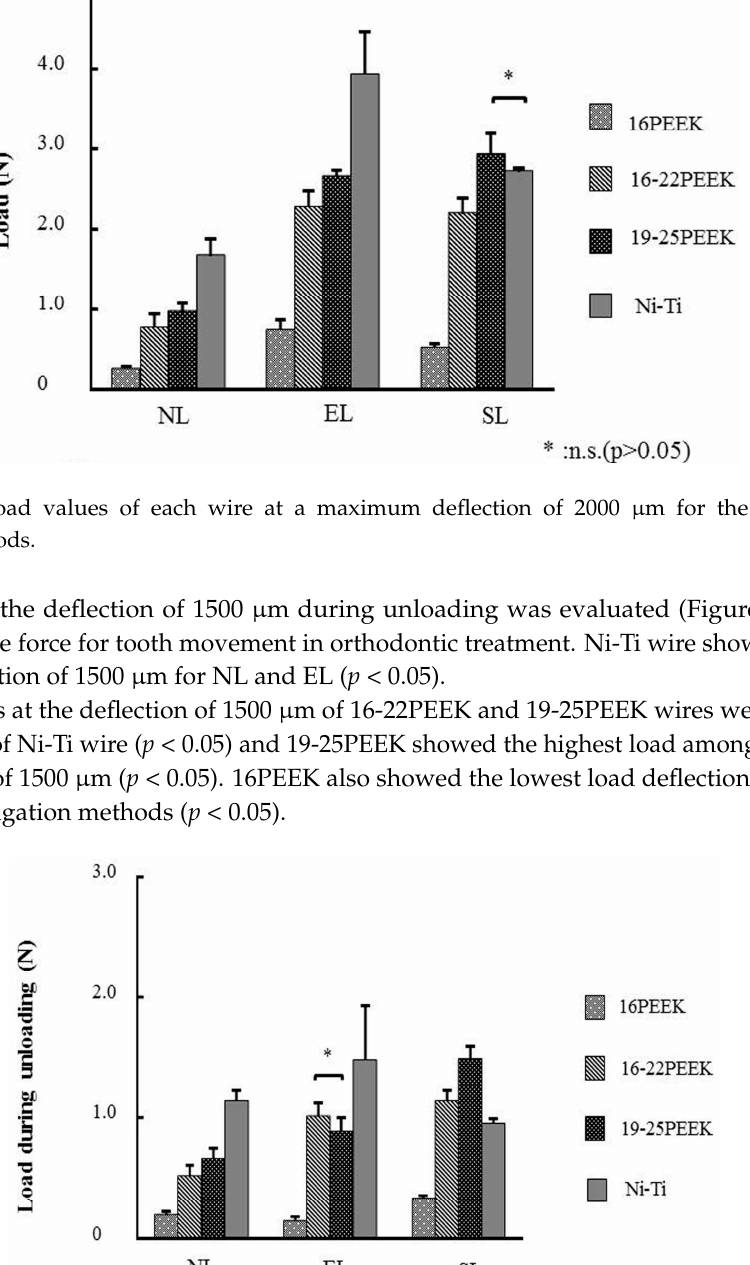
Figure 1. Load-deflection curves by three-point bending test ( a ) no-ligation; ( b ) elastomeric ligature; ( c ) slot lid.